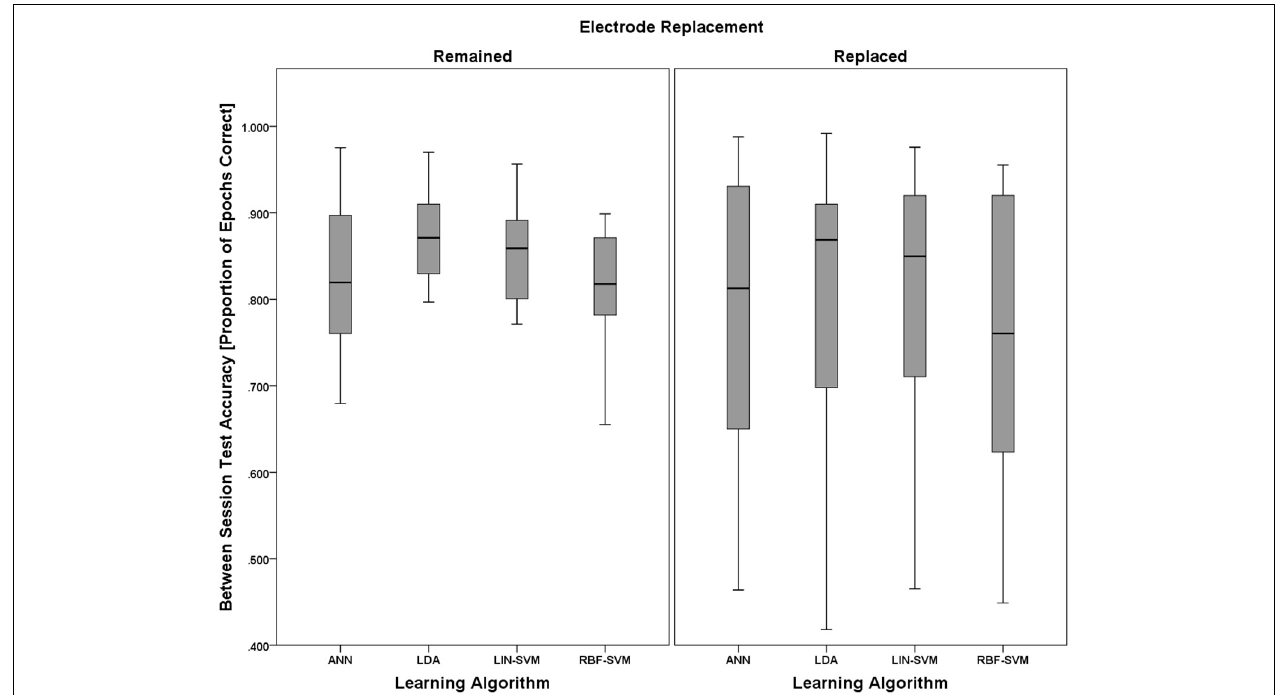
FIGURE 14 | Boxplots showing between-session classifier accuracy data representative of the 2 (electrode replacement, between) × 4 (learning approach, within) mixed model ANOVA. The between-subjects factor of electrode replacement was not significant. The effect of learning approach was significant and is probed further in Figure 15 . The boxplots shown represent the median (line inside